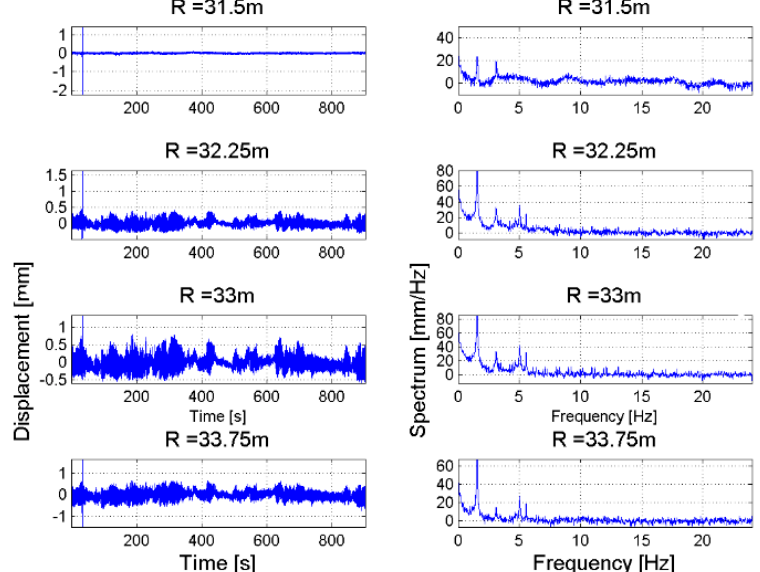
Figure 15. Occhito dam, Carlantino. Time series of displacements ( left ) and corresponding frequency spectrum ( right ) of targets belonging to the pedestrian bridge located at range distance in the interval [30 m, 35 m].